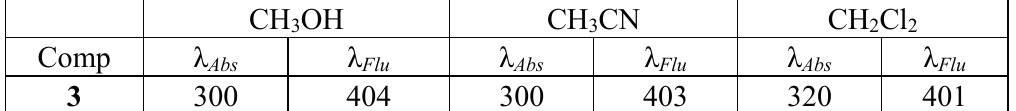
Table 1. Photophysical data: electronic absorption ( Abs. ) and fluorescence ( Flu. ) of 3 .